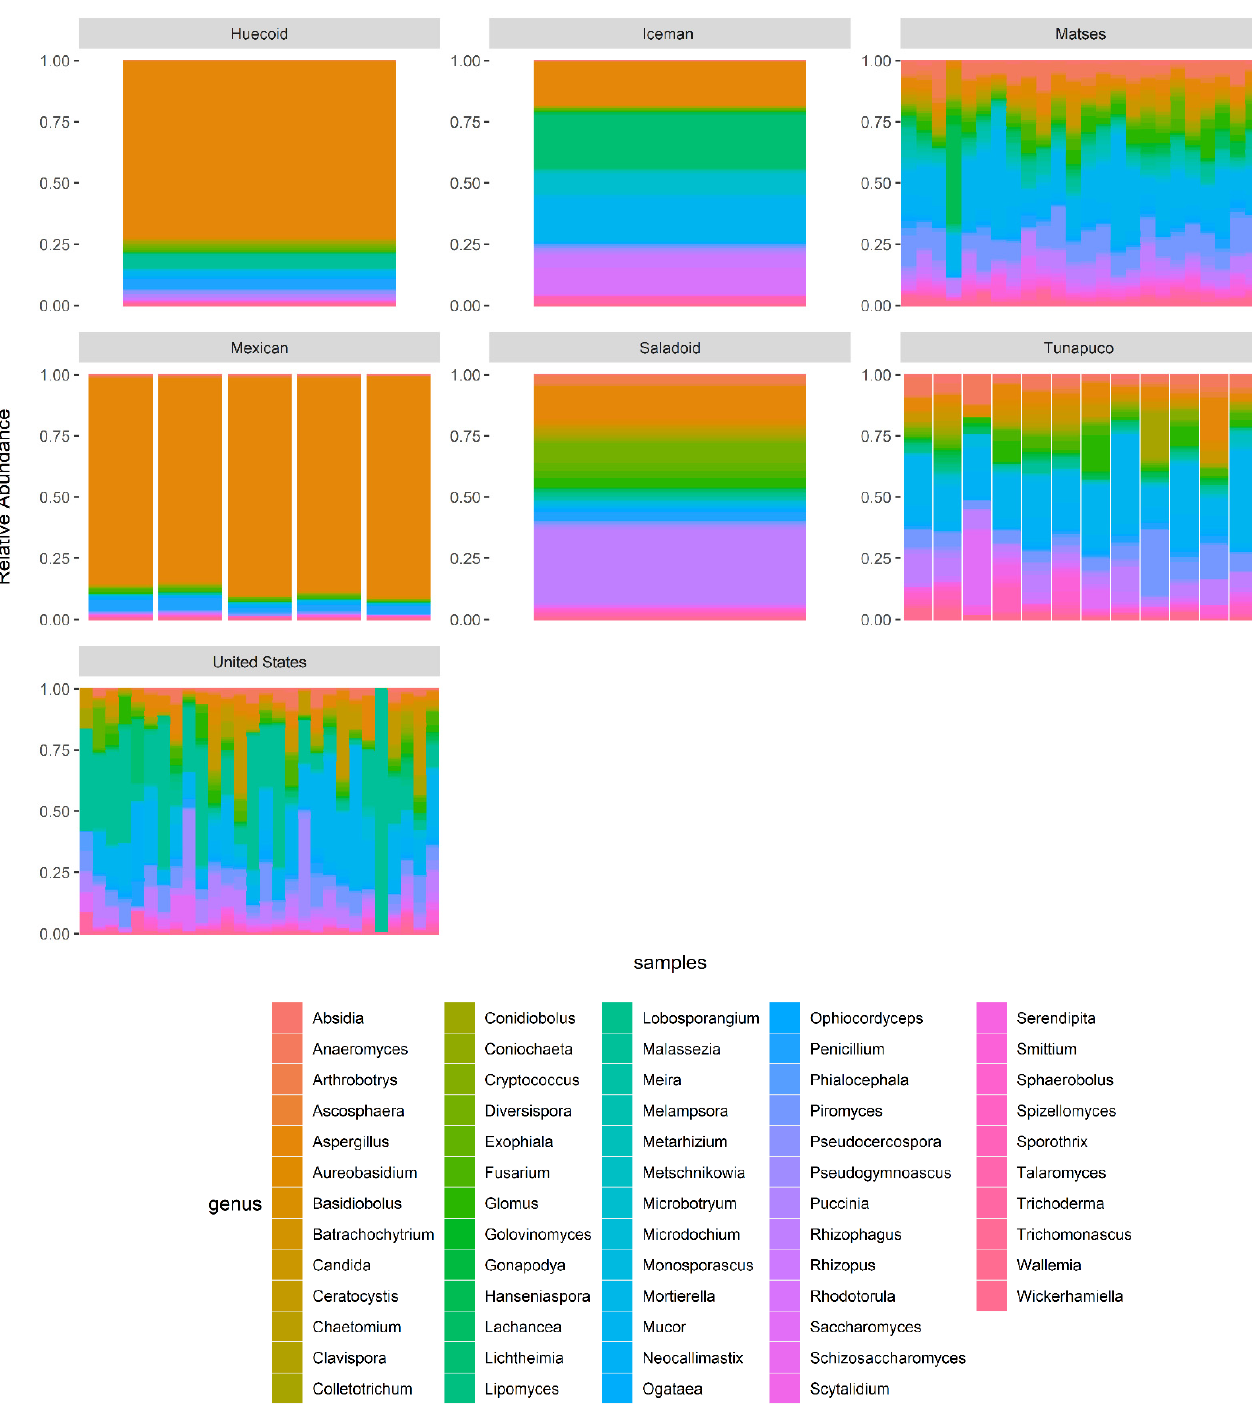
Figure 7. Gut mycobiome composition at the genus level, relative abundance of the fungal genera in the gut mycobiome of the ethnic groups (observed more than three times in at least 20% of the samples).